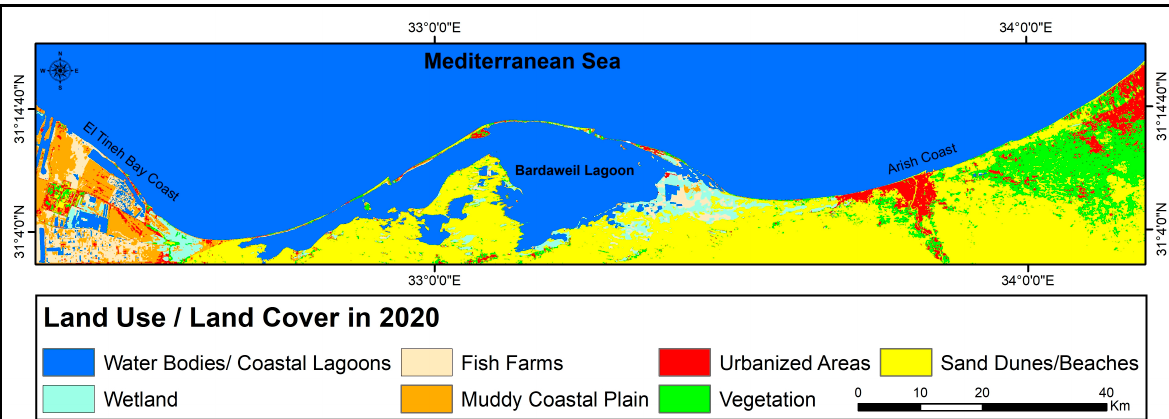
Table 1. Landsat images used in this